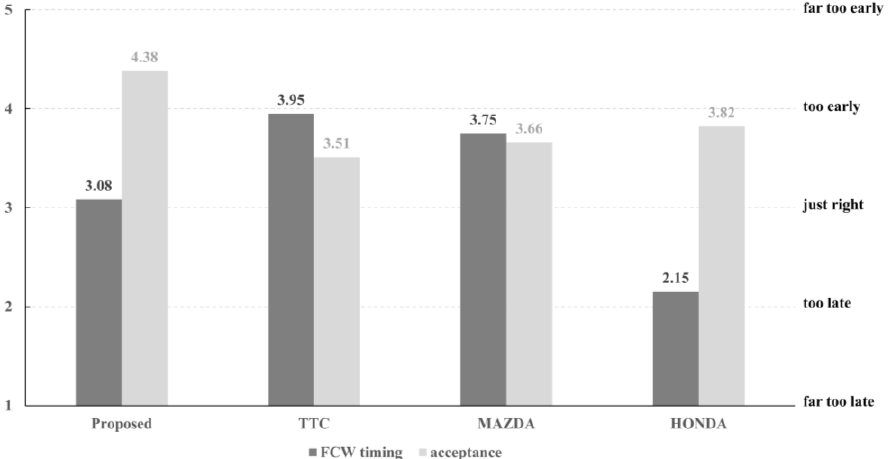
Figure 8. The subjective utility expressed in terms of the FCW timing and acceptance of the proposed model.